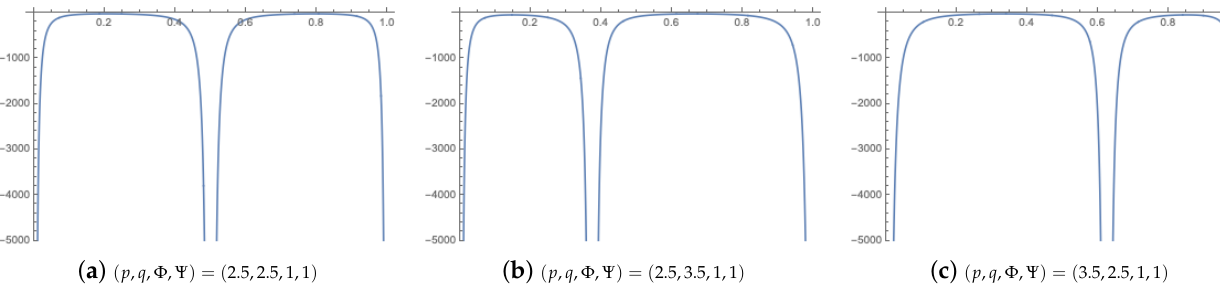
Figure 4. Schwarzian derivatives of r G p , q ,1,1 ( x ) = rx p − 1 ( 1 − x ) q − 1 .